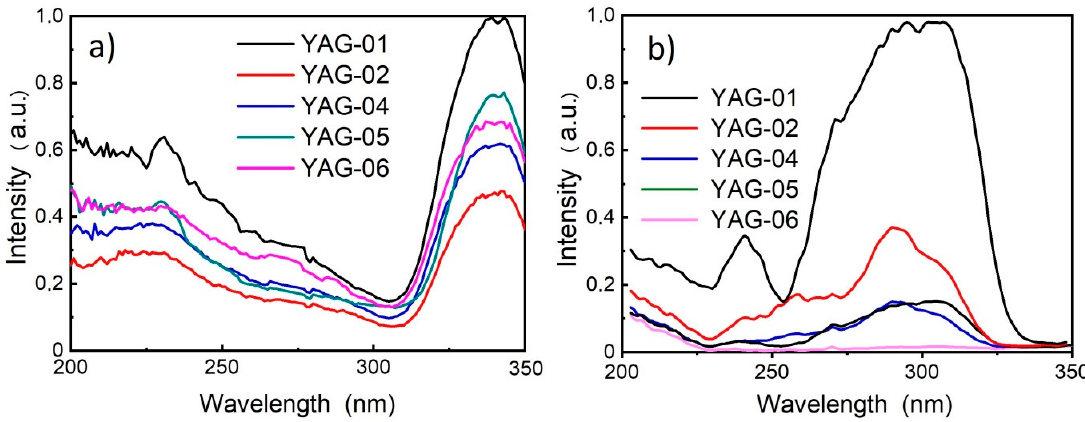
Figure 4. ( a ) Excitation spectra of luminescence in the visible region (LV; λ em = 540 nm); ( b ) excitation spectra of luminescence in the ultraviolet region (LUV; λ em = 370 nm) in C-YAG phosphors.